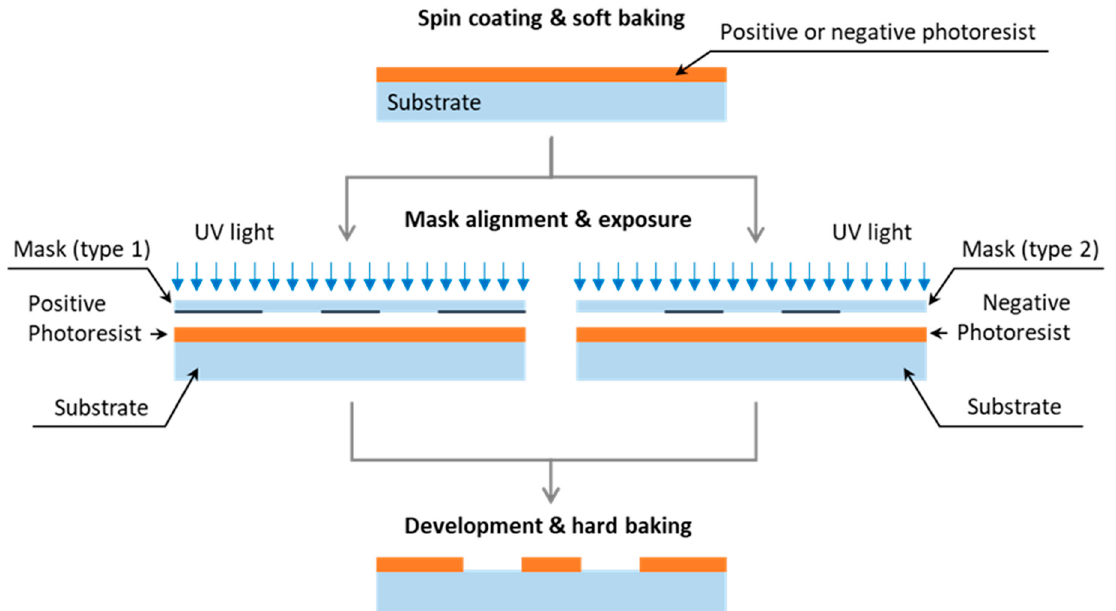
Figure 2. Photolithography process.